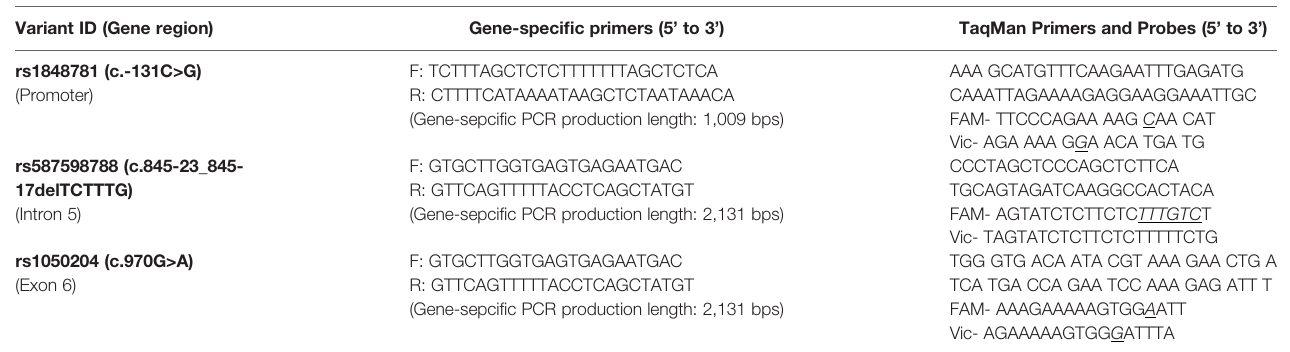
TABLE 1 | Primers and probes of TaqMan allele discrimination assays for FCGR1A variants. Variant ID (Gene region) Gene-speci fi c primers (5 ’ to 3 ’